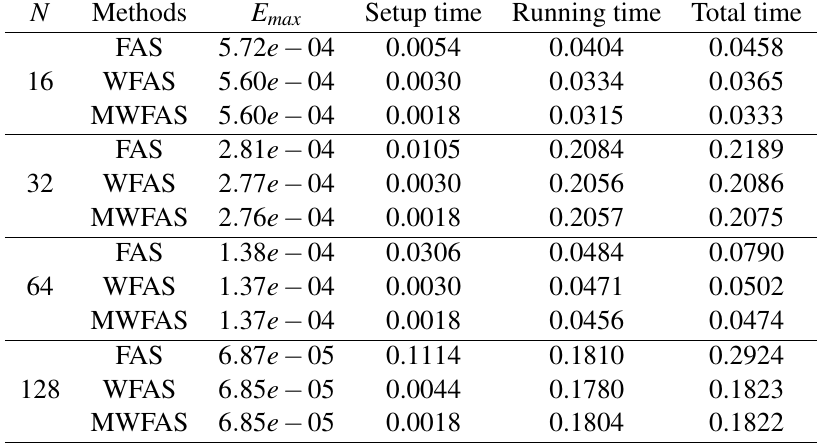
Table 8 Maximum error and CPU time (in seconds) of the methods of test problem